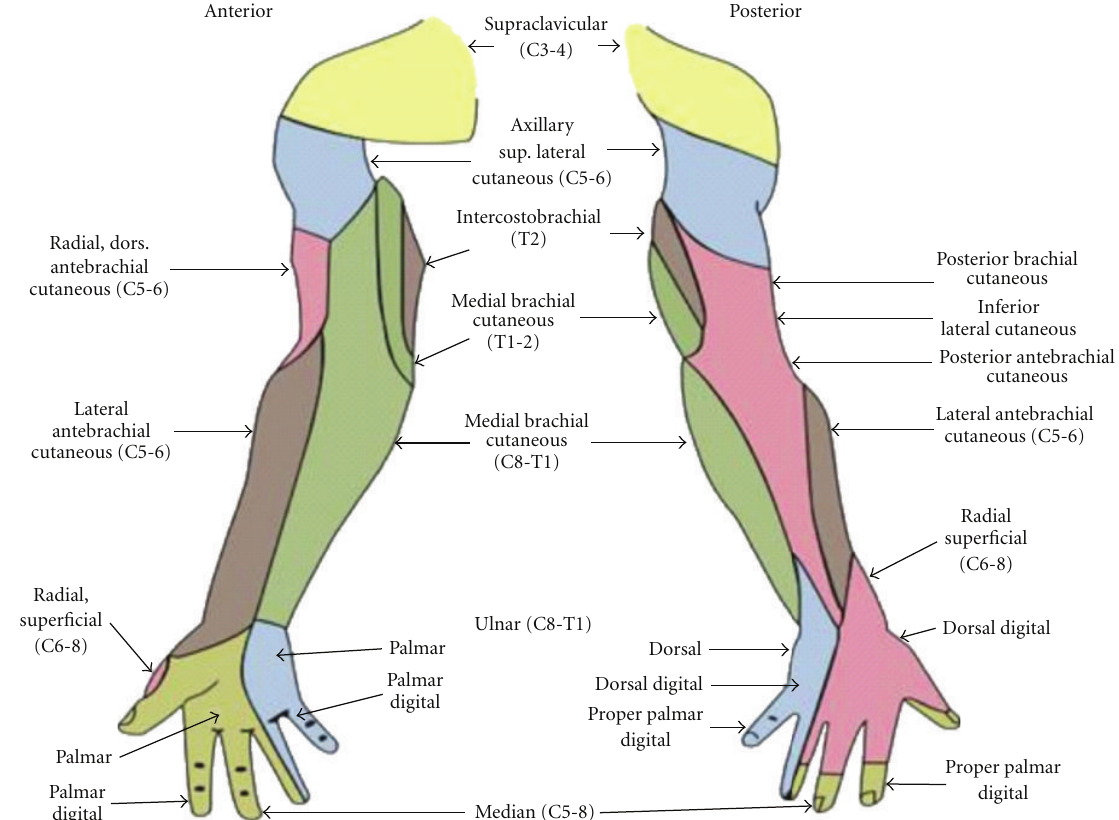
Figure 1: Cutaneous innervation of the upper extremity. Note the significant contributions of the cutaneous branches of the plexus. (Courtesy From Wikimedia Commons, file: Gray’s Anatomy 812 and